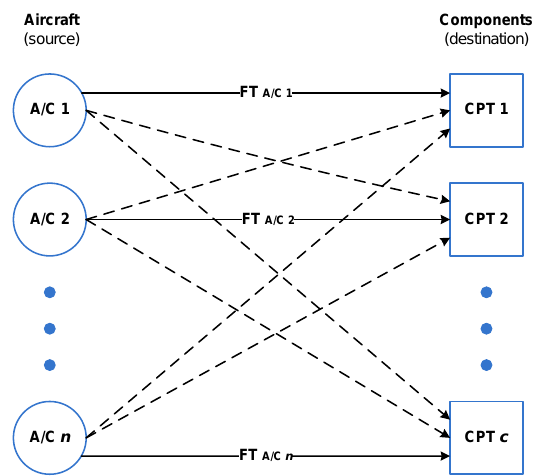
Figure 5. Representation of the CMP assignment